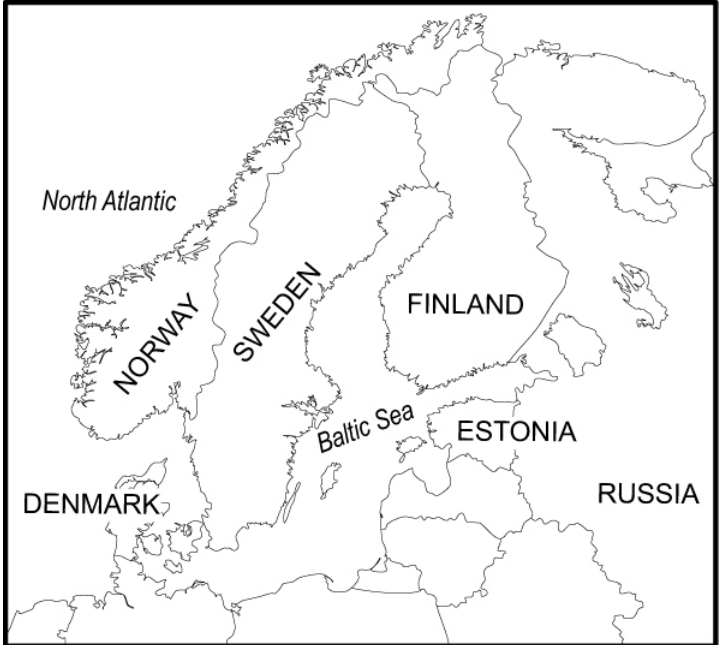
Figure 2. Map of the region around the Baltic Sea in north-western